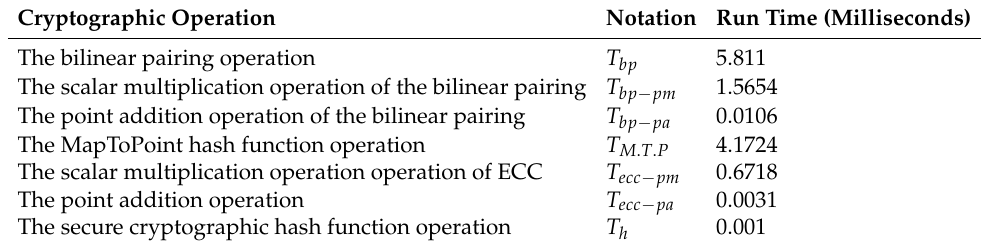
Table 3. The run times of cryptographic